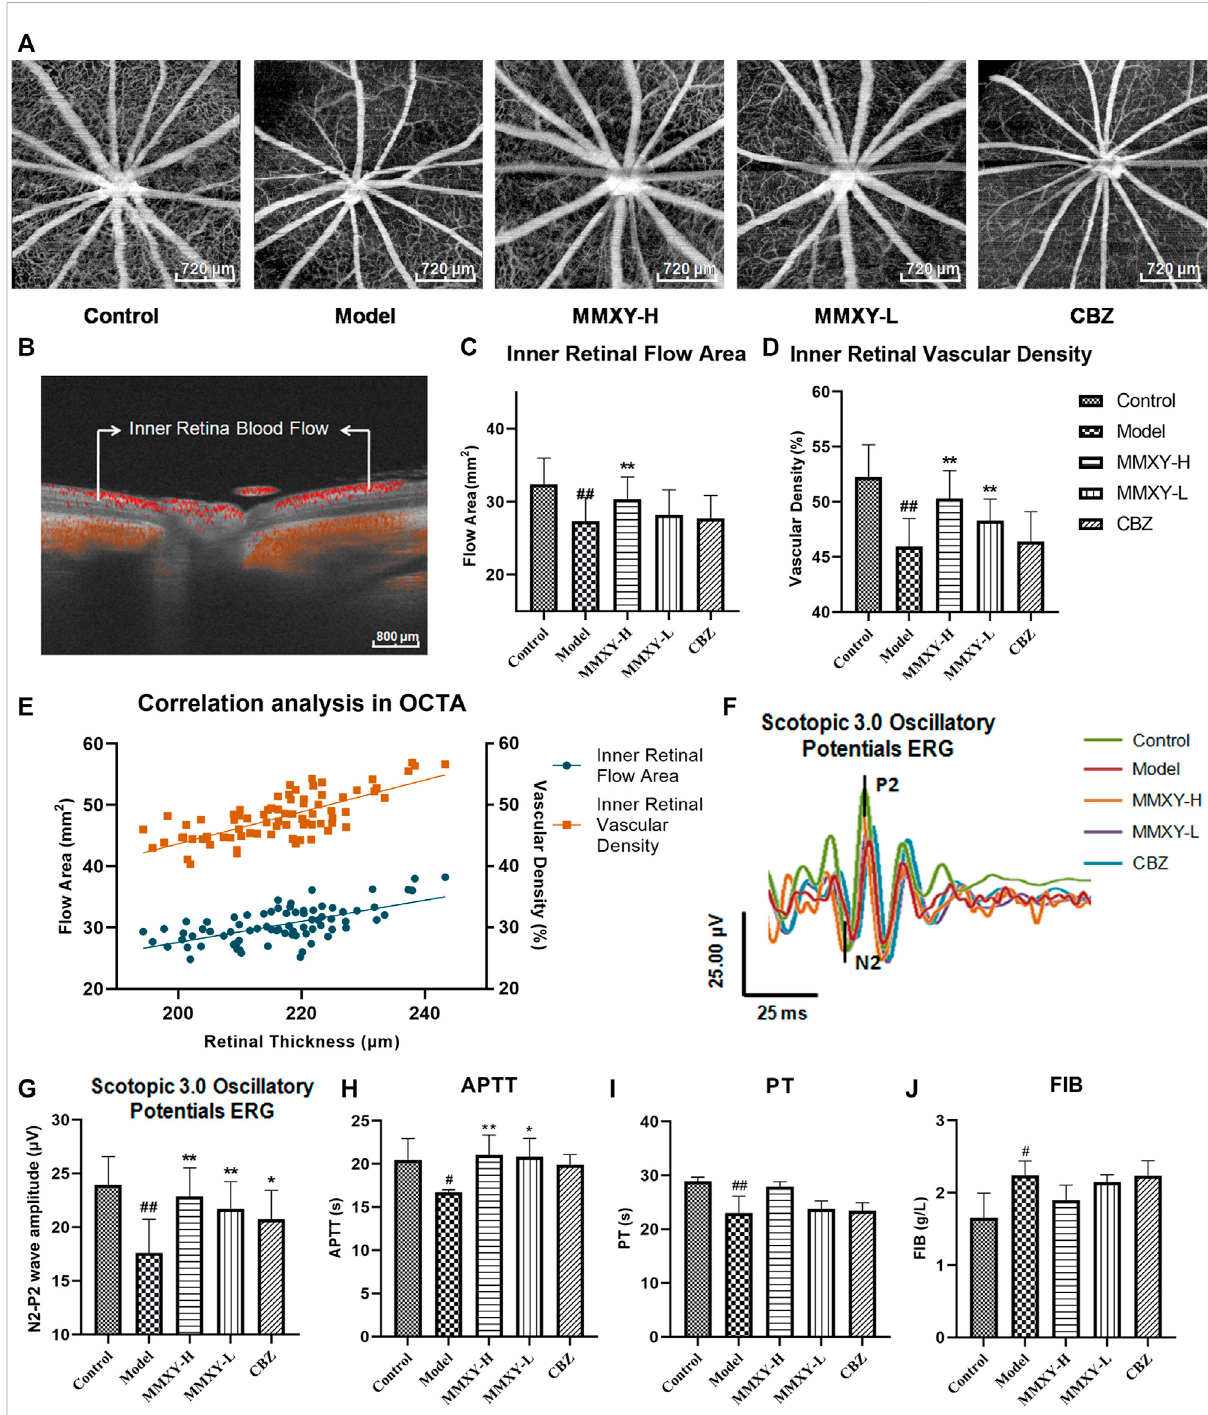
FIGURE 6 Effect of MMXY on retinal blood fl ow in CUMS rats. (A) Inner retina enhanced angio image in OCTA. Scale bars = 720 µm. (B) OCTA B-scan of retinal blood fl ow. Scale bars= 800 µm (C,D) The innerretinal blood fl owareaand vascular density ineach group(n =16 eyes). Results are shownas the mean ± SD. (E) Correlation analysis of inner retinal fl ow area and vascular density with retinal thickness (r green = 0.63 p < 0.01, r orange = 0.73 p < 0.01). (F,G) EffectsofMMXYonOPswaveformcurveandamplitudeinCUMSrats(n=8eyes).Resultsareshownasthemean±SD. # p < 0.05and ## p < 0.01vs.controlgroup;* p < 0.05and** p < 0.01vs.modelgroup (H – J) EffectsofMMXYonAPTT,PTandFIBinCUMSrats(n=6rats).Resultsare shown as the median (P25, P75). # p < 0.05 and ## p < 0.01 vs. control group; * p < 0.05 and ** p < 0.01 vs. model